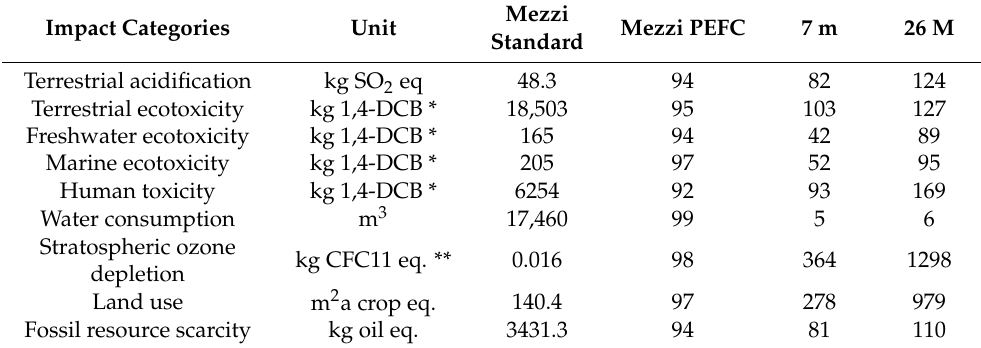
Table 1. Comparison (in %) between the environmental results per functional unit from the “Mezzi” standard and the remaining cropping systems under